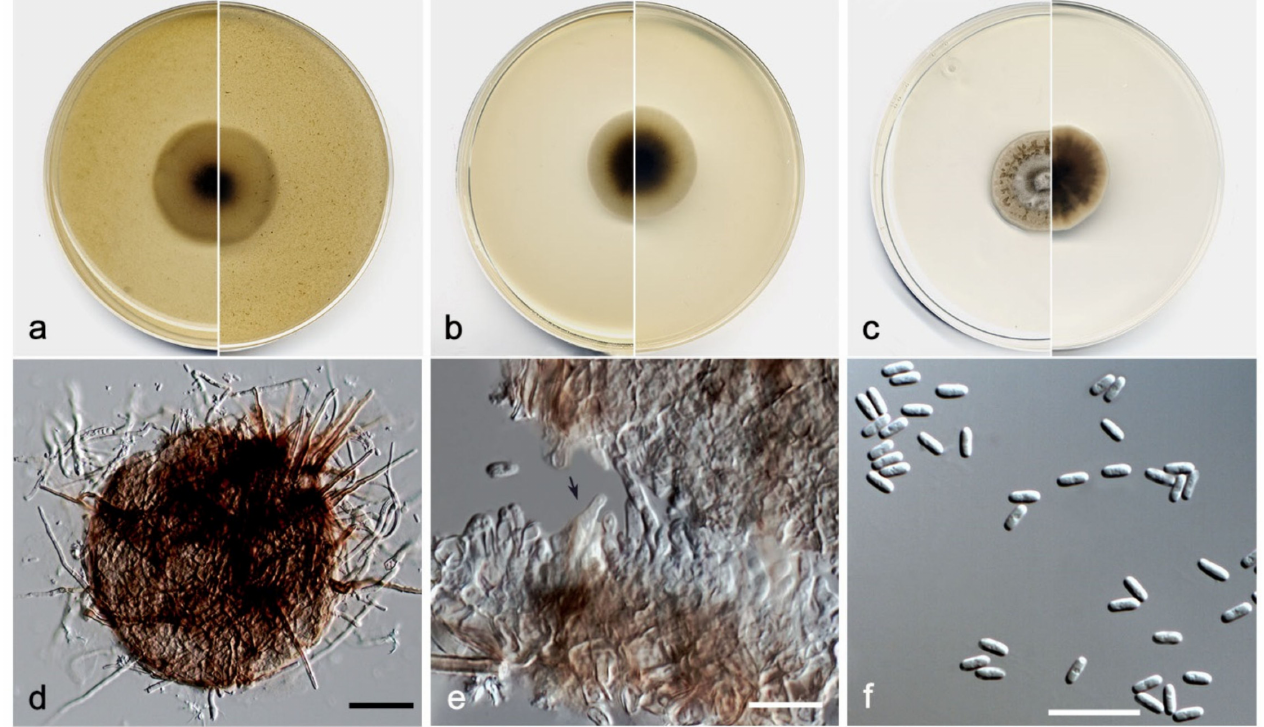
Figure 15. Pyrenochaetopsis cylindrospora FMR 18801 ( a ) Colonies on OA ( b ) MEA ( c ) and PDA after two weeks at 25 ± 1 ◦ C (surface, left; reverse, right); ( d ) Pycnidium; ( e ) Conidiogenous cells (black arrow); ( f ) Conidia. Scale bars: ( d ) = 20 µ m, ( e , f ) = 10 µ m. Diagnosis: The closest species to P. cylindrospora is P. confluens . Morphologically, P. cylindrospora differs from P. confluens because the former produces lager setae (35–75 µ m vs. 5–22.5 (–35) µ m) and bigger conidia (5–6 × 1.5–2 µ m vs. 2–4 × 2–2.5 µ